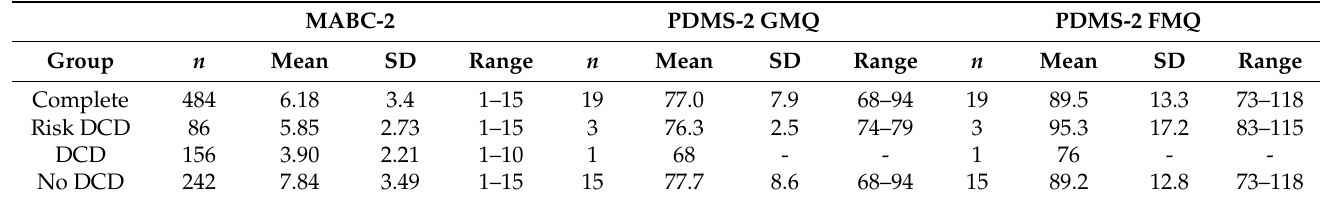
Table 2. MABC-2 standard scores (mean norm score is 10, SD = 3) or PDMS-2 scores at the last diagnostic assessment of the group with a clinical DCD, at-risk DCD, or no DCD